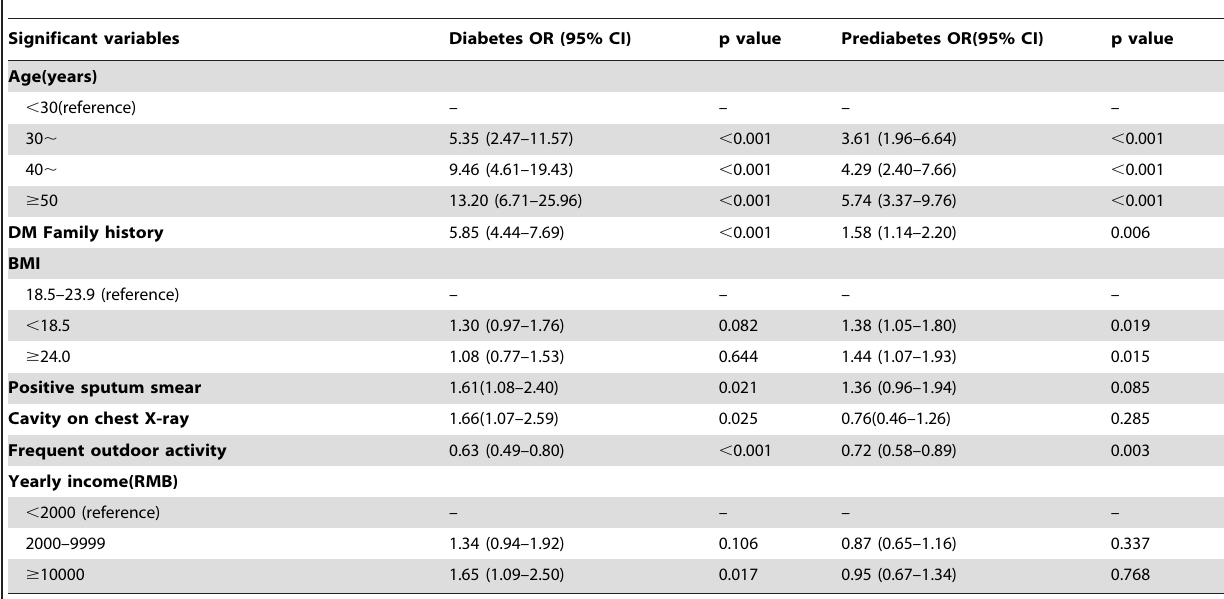
Table 4. Multivariate-adjusted odds ratios for diabetes and prediabetes in pulmonary tuberculosis